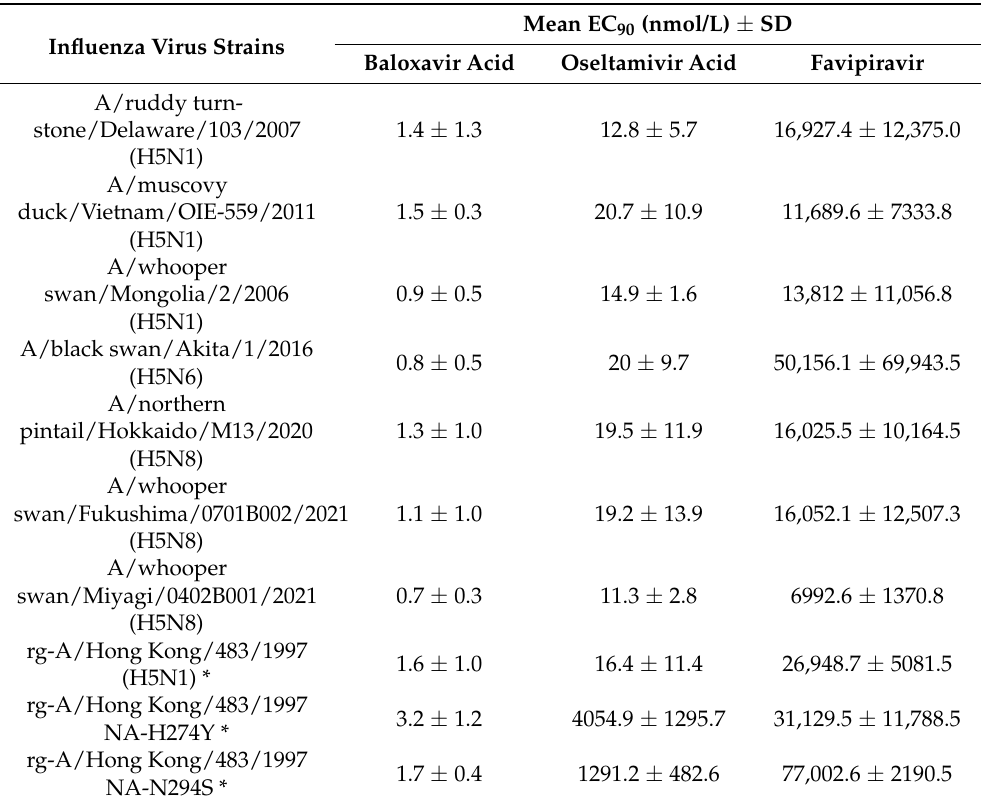
Table 1. Antiviral activities of baloxavir acid and other reference compounds against HPAIV in viral yield reduction